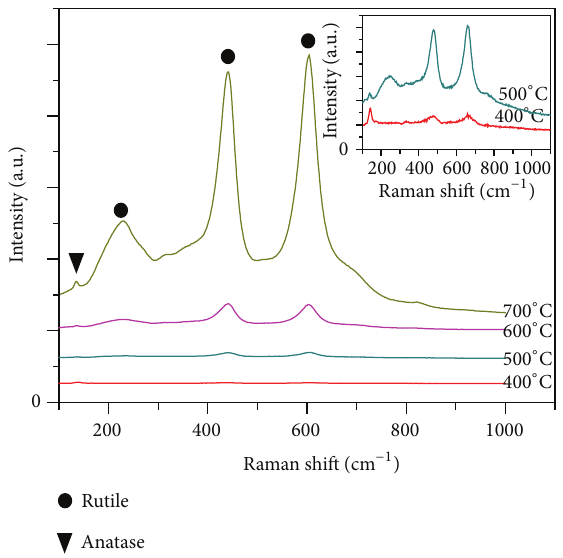
Figure 3: The Raman spectra of TiO 2 annealed at different temper-